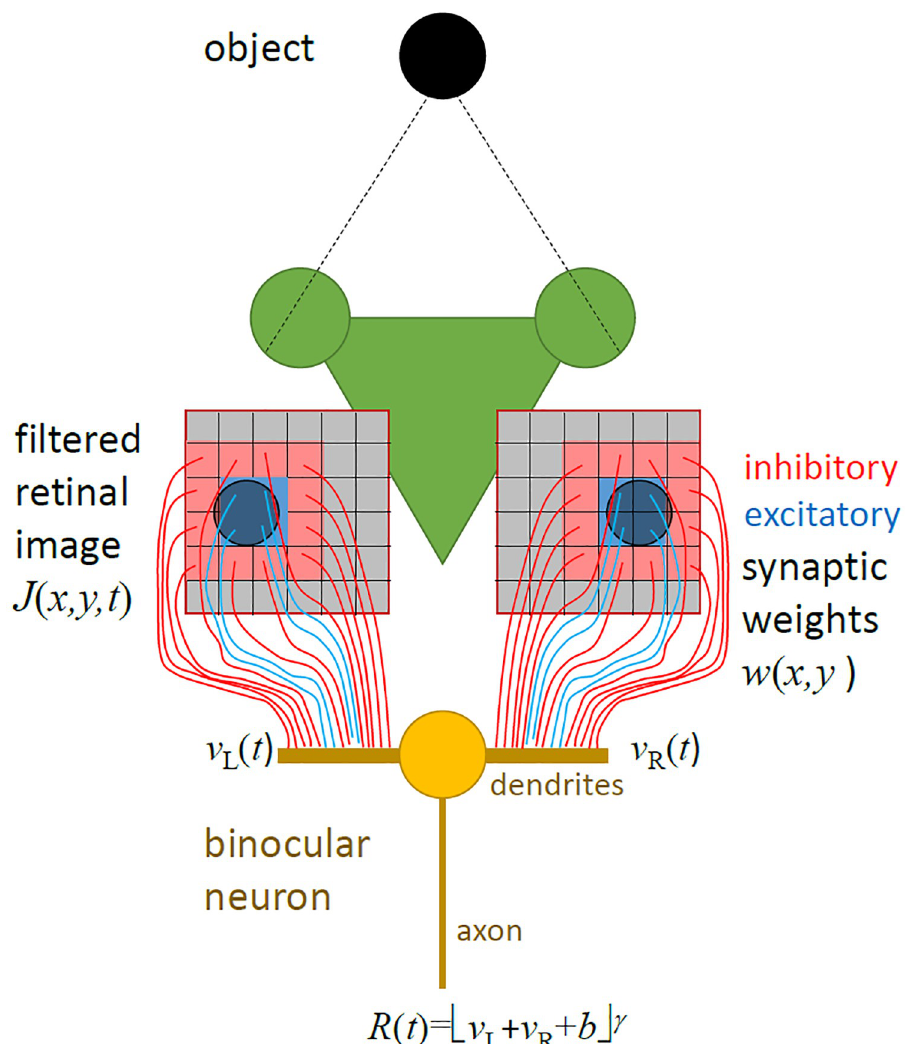
Fig 2. Schematic diagram of the disparity energy model. The model postulates a binocular neuron which receives input from each eye, representing the inner product of the retinal image with a receptive field function. The receptive field function represents the effect of stimulation at each point in the retinal image on the binocular neuron, and can be thought of as an effective synaptic weight (though the real pathway is multisynaptic). Red and blue are used to represent inhibitory and excitatory weights respectively. The activity of the neuron is then represented as a nonlinear function of its total input. In the original energy model [24], this nonlinearity was a threshold at 0 followed by squaring; we generalise the model to allow for a non-zero threshold − b and arbitrary exponent γ . Mathematical symbols are defined below, Eqs (1) and (2). We postulate that this binocular neuron synapses onto a motoneuron in such a way that the instantaneous strike probability is proportional to the activity of the binocular